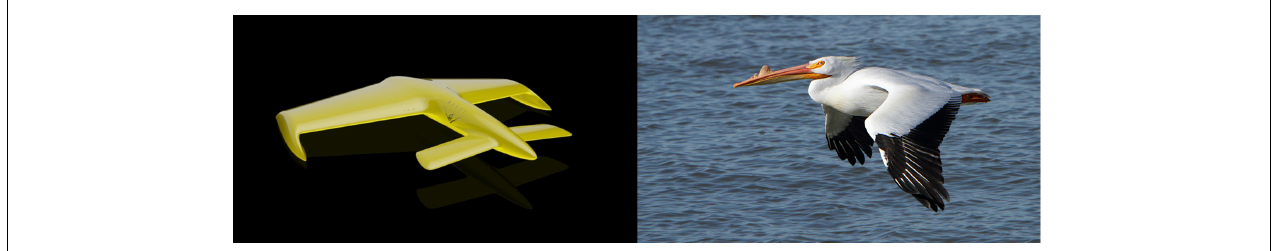
FIGURE 6 | The Shearwater vehicle concept under development (Image courtesy MBARI 2012 ©